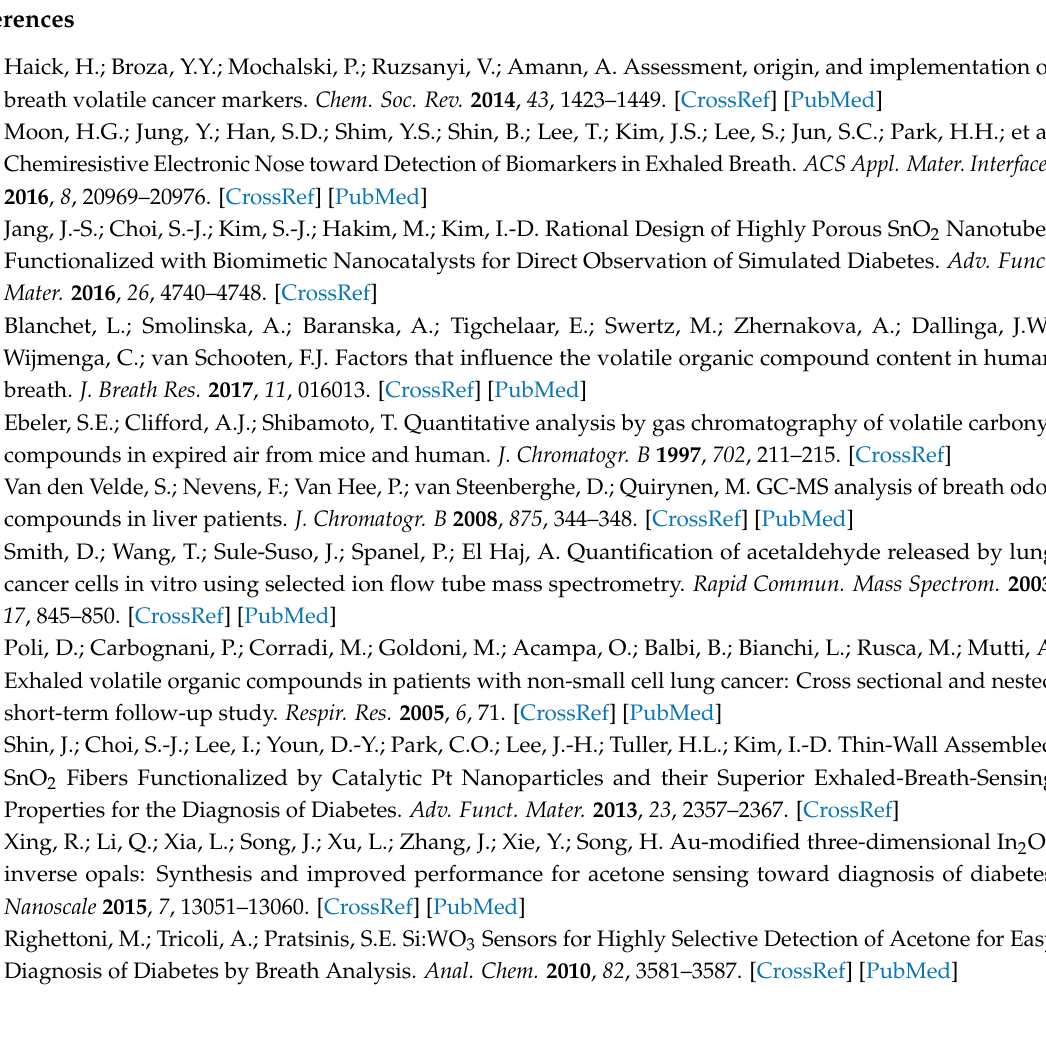
s1, Figure S1: The differences among the synergetic, coupling and interlocking p+n FET circuit for MOX acetone sensor, Figure S2: (a) V DS -I DS curves of FET 2SK427, V GS changes from − 5 V to 0 V (step is 0.1 V). (b) V DS -I DS curves of FET 2SJ103, V GS changes from 0 V to 5 V (step is 0.1 V), Figure S3: I DS –V GS curves of FETs 2SK427 (a) and 2SJ103 (b). (c) and (d) the calculation of V T , Figure S4: The approximate curve of interlocking p+n FET circuit with R L of 7.1 M Ω (red solid curve). The blue dash curve is the fitting curve of the maximum points from five solid curves of n-type FET 2SK427 circuit with R L 7.1, 10, 20, 30 and 50 M Ω respectively. The fitting curve formula is R = 4.59 I − 1.04 (r 2 = 0.992), Figure S5: (a) Output voltage of Mn doped ZnO (MZO) in the traditional circuit and the interlocking p+n FET circuit with R L ON or OFF. (b) Circuit schematic of the static gas sensing test